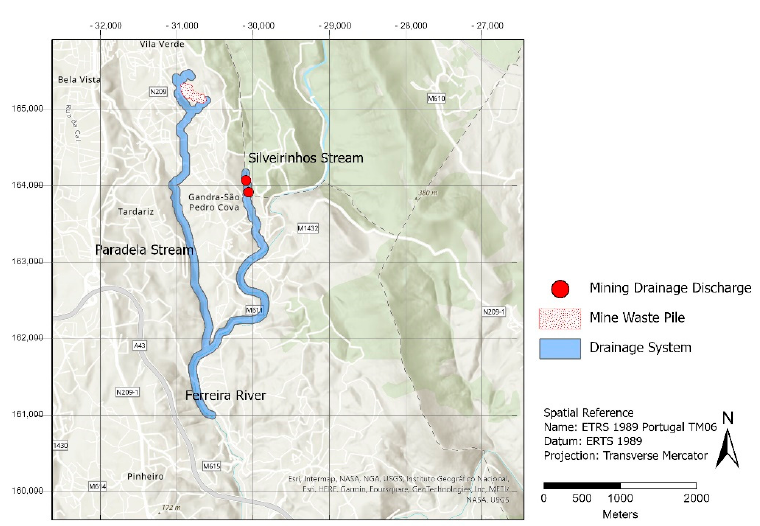
Figure 4. Main water streams and temporary water lines affected by the